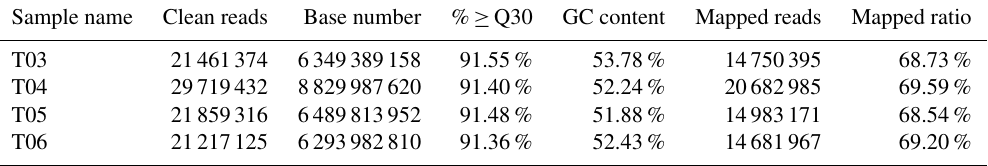
Table 2. Summary data of the sequencing assembly.